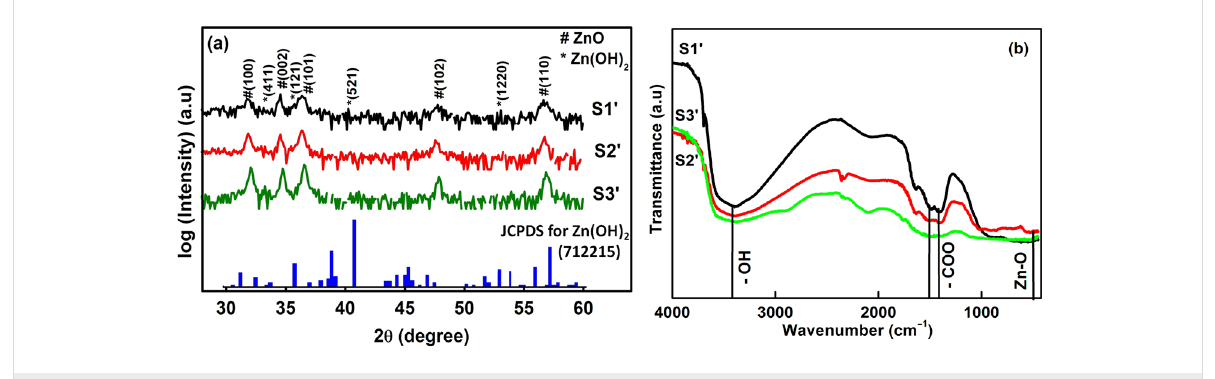
Figure 5: (a) XRD patterns of aged samples S1’, S2’ and S3’ in log scale indexed with peaks of ZnO and Zn(OH) 2 , (b) FTIR spectra of the aged samples S1’, S2’ and S3’ showing various groups present in the sample.